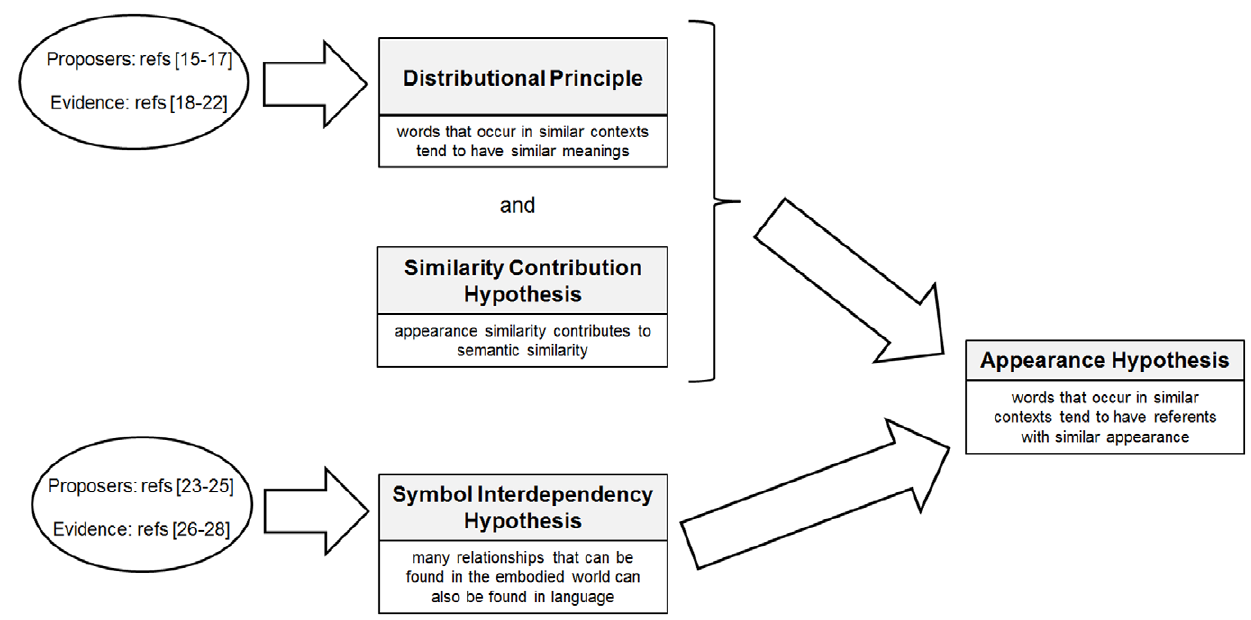
Figure 2. Arguments leading to the Appearance Hypothesis.